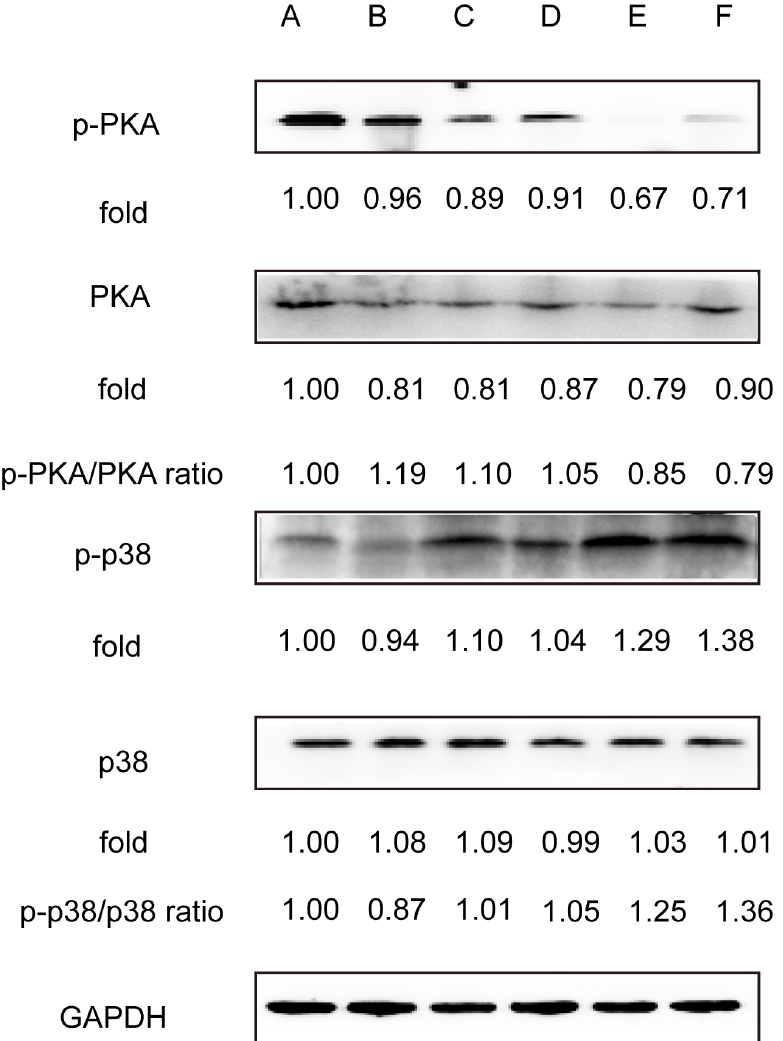
FIGURE 7 - Western blot analysis of activation of PKA and p38 in heart tissues of nude mice (A: sham; B: DOX+SS; C: DOX+PSO- PLN (3 mg/kg); D: DOX+PSO-PLN (6 mg/kg); E: DOX+PSO-PLN (9 mg/kg); F: